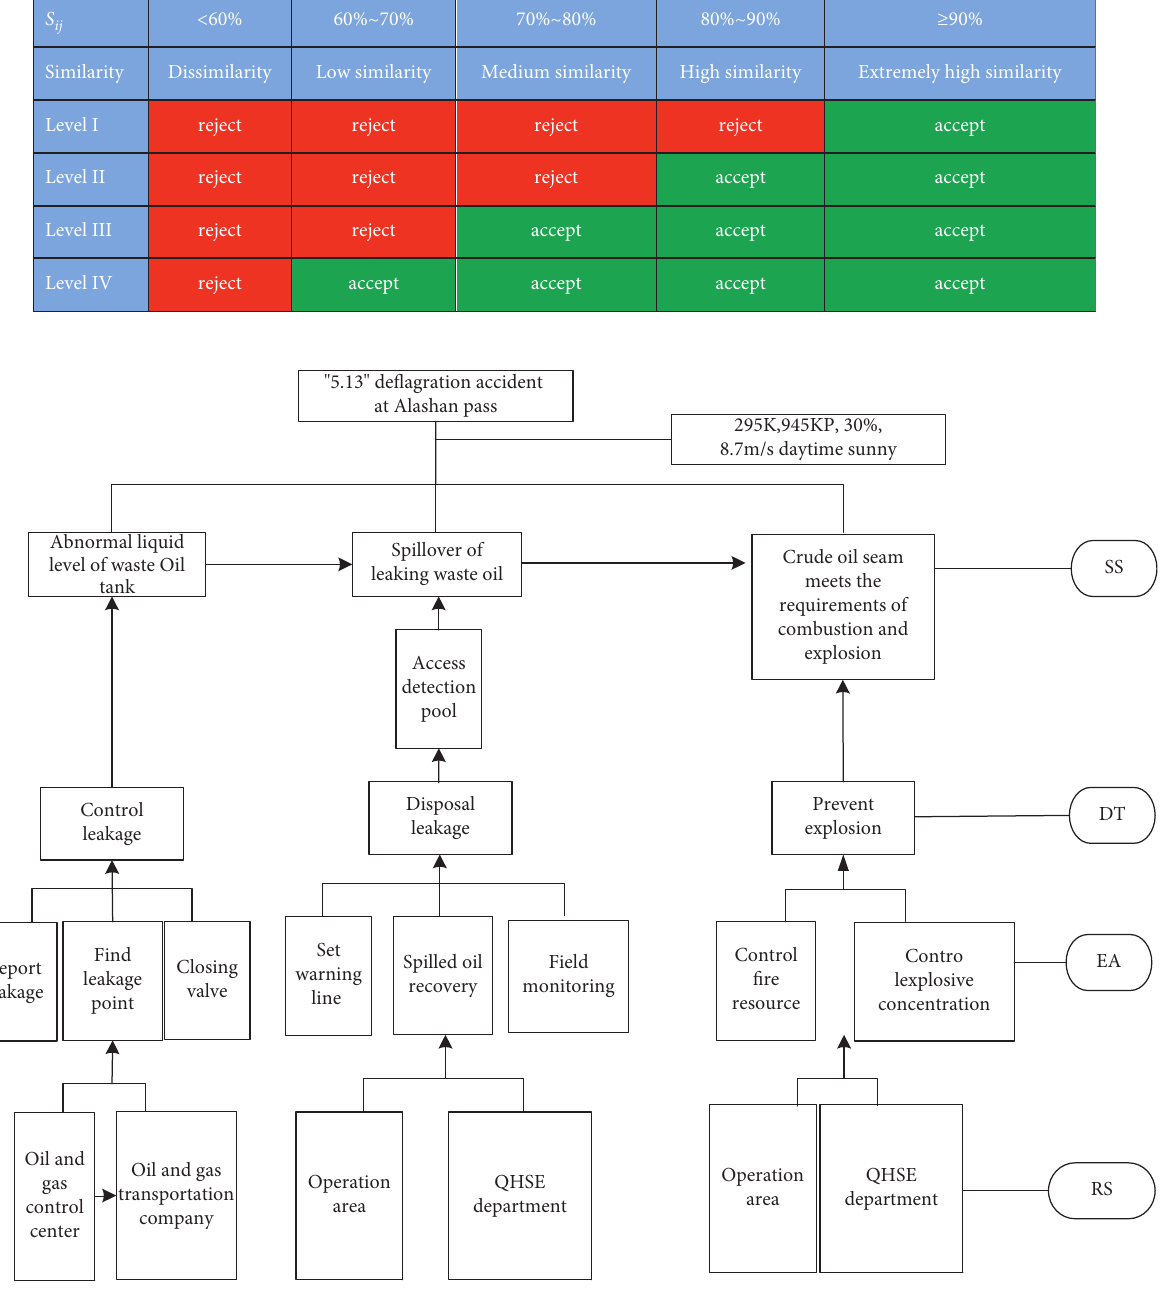
Table 3: Evaluation matrix similarity of emergency exercise scenarios.